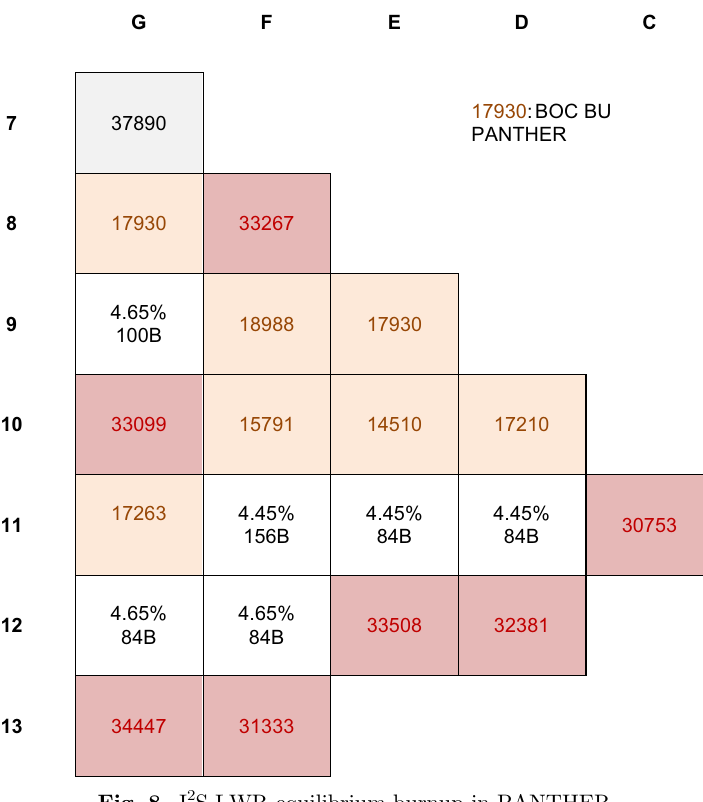
Fig. 8. I 2 S-LWR equilibrium burnup in PANTHER.